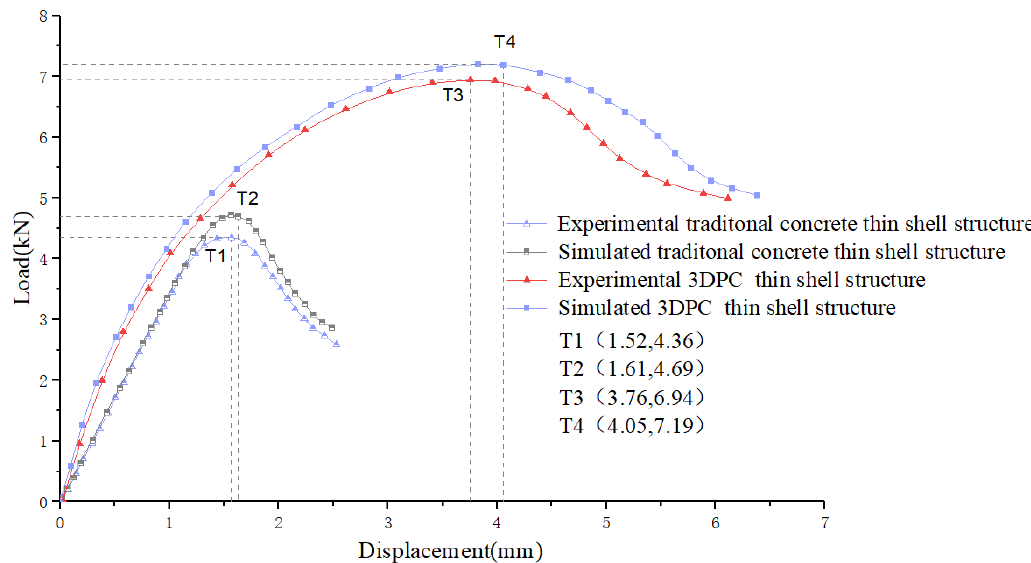
Figure 17. The load-displacement curves of the experimental and FEM results.